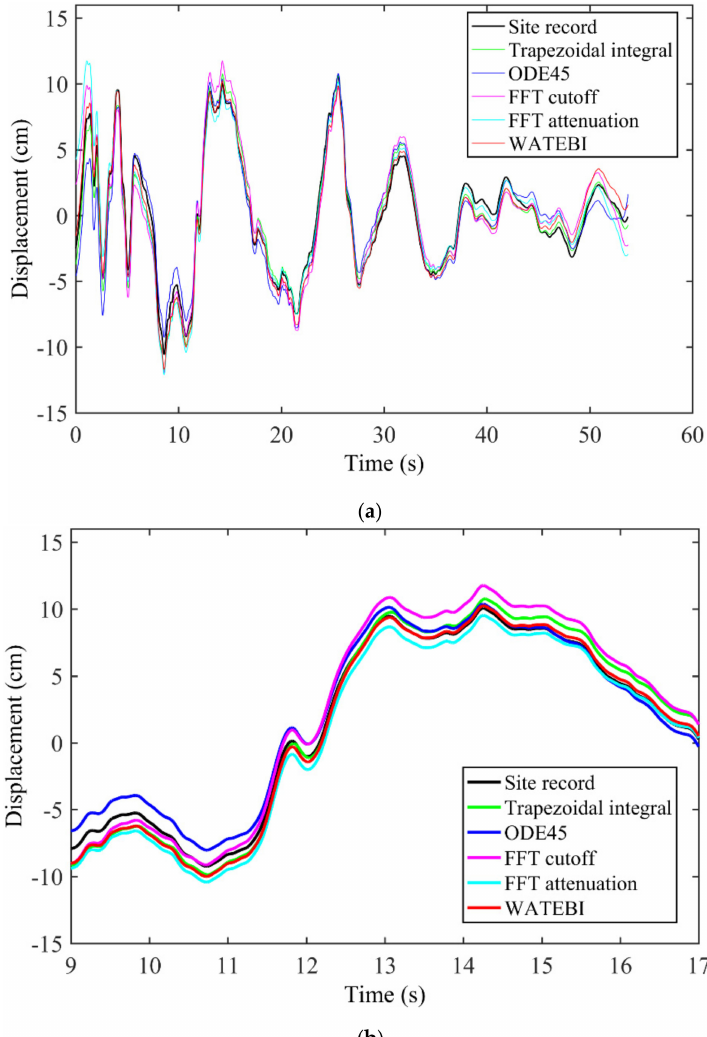
Figure 9. Displacement of El Centro ground motion: ( a ) Full duration; ( b ) Enlarged detail at largest